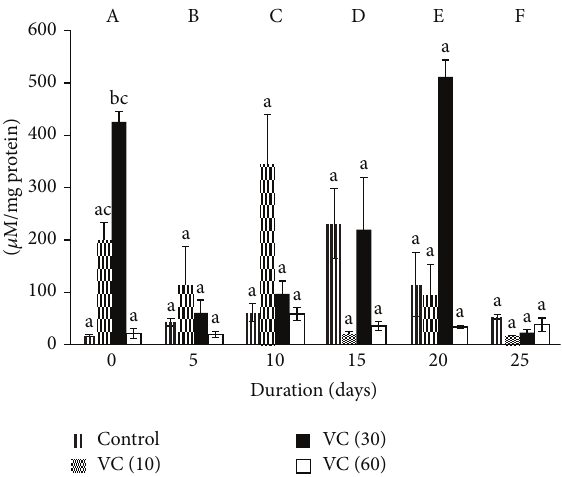
Figure 3: Thiobarbituric acid reactive substances in plasma isolated from stored blood. Values are mean ± SE of five animals/group. VC (10): vitamin C (10mM), VC (30): vitamin C (30mM), and VC (60):